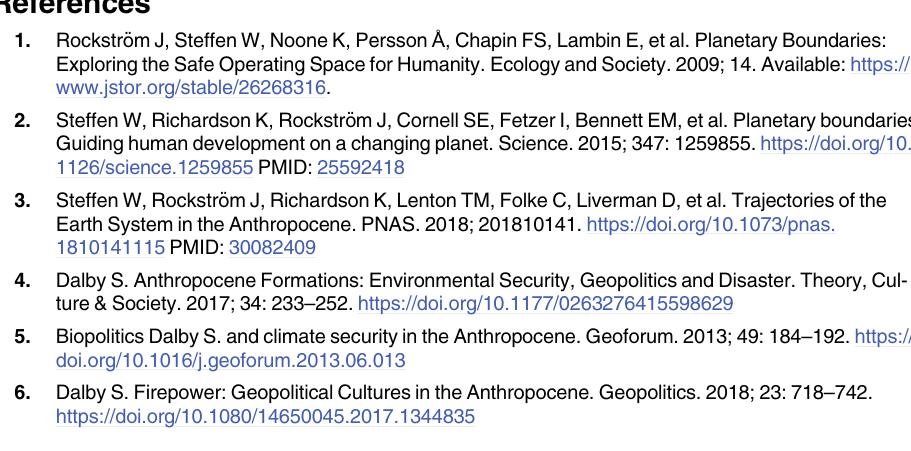
) and corresponding s